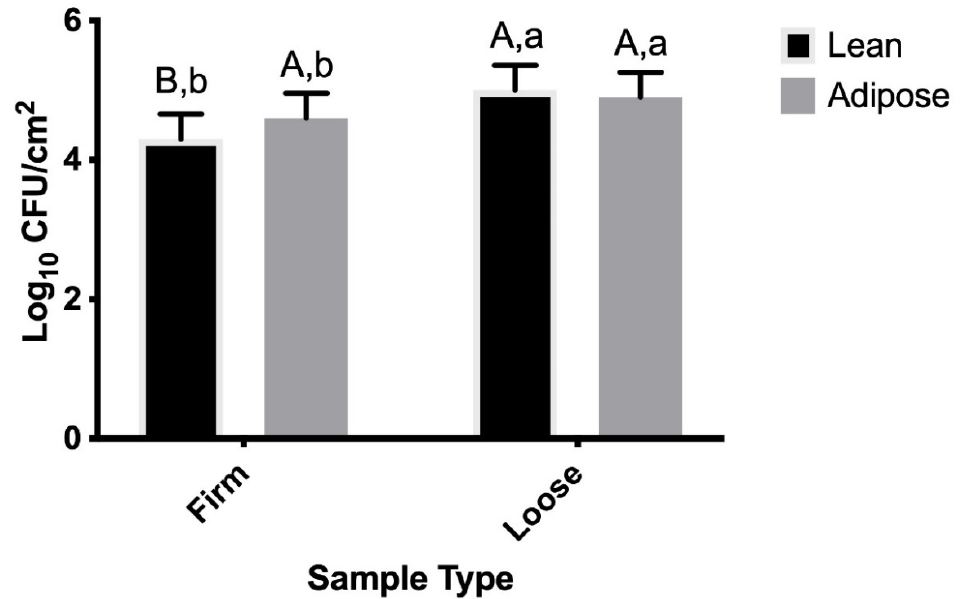
Figure 4. Populations of Shiga toxin-producing Escherichia coli (STEC) cells grown in tryptic soy broth (TSB) represent loose and firm attachment to lean and adipose beef brisket tissues within 20 min post-inoculation. Sample type × tissue type was significant ( p < 0.0001). As the time × sample type × tissue type interaction was not significant ( p > 0.05), data for each time point are combined. A,B Observations with different superscripts within sample type vary statistically ( p ≤ 0.05). a,b Observations with different superscripts within tissue type vary statistically ( p ≤